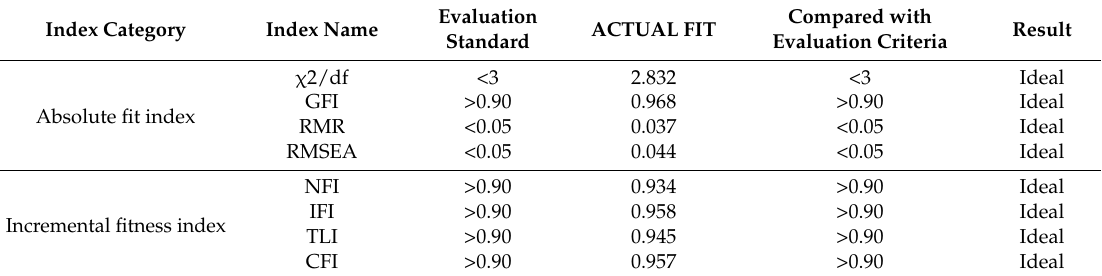
Table 4. Overall fitness evaluation standard and fitting evaluation result of structural equation model.